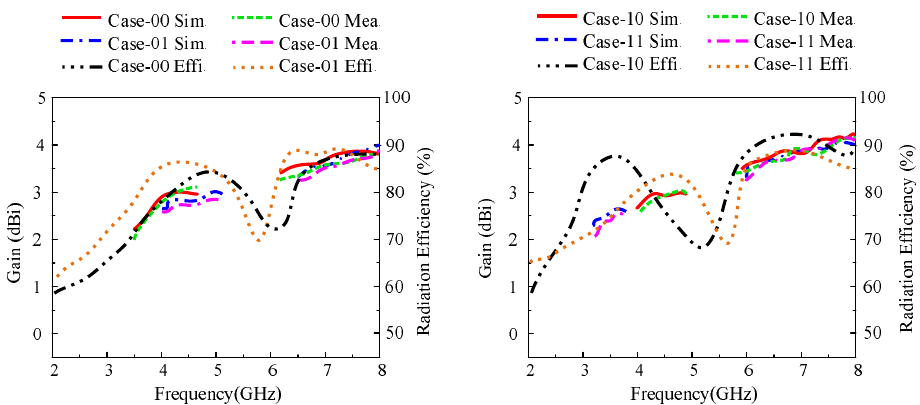
Figure 8. Simulated and measured gain along with radiation efficiency.